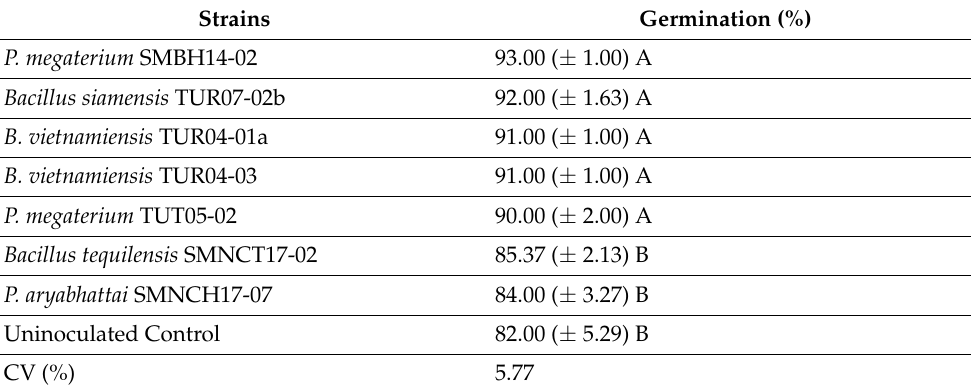
Table 4. Effect of rice endophytic bacteria on the germination of Oryza sativa var. “Bellavista”.